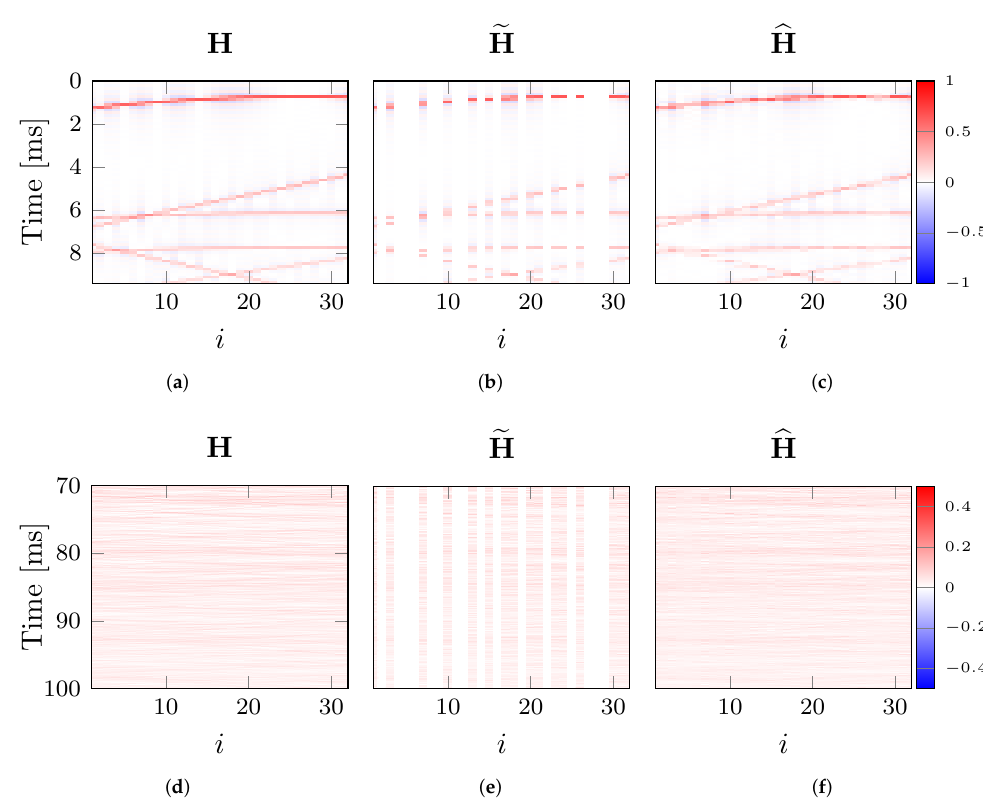
Figure 5. Example of a RIR image H ( a , d ), the observed data obtained through the proposed technique ( c , f ). ( a – c ) The time axis is zoomed around the direct path and the first reflections. ( d – f ) The time axis is zoomed between 70ms and